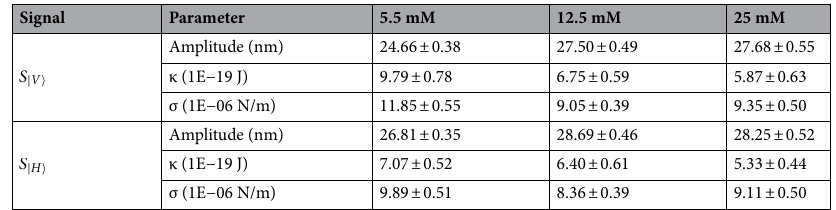
Table 2. Membrane mechanical parameters. Comparison between the average mechanical parameters for spots S | V � and S | H � at three different D-glucose concentrations. Mean values are presented with the standard error of the mean